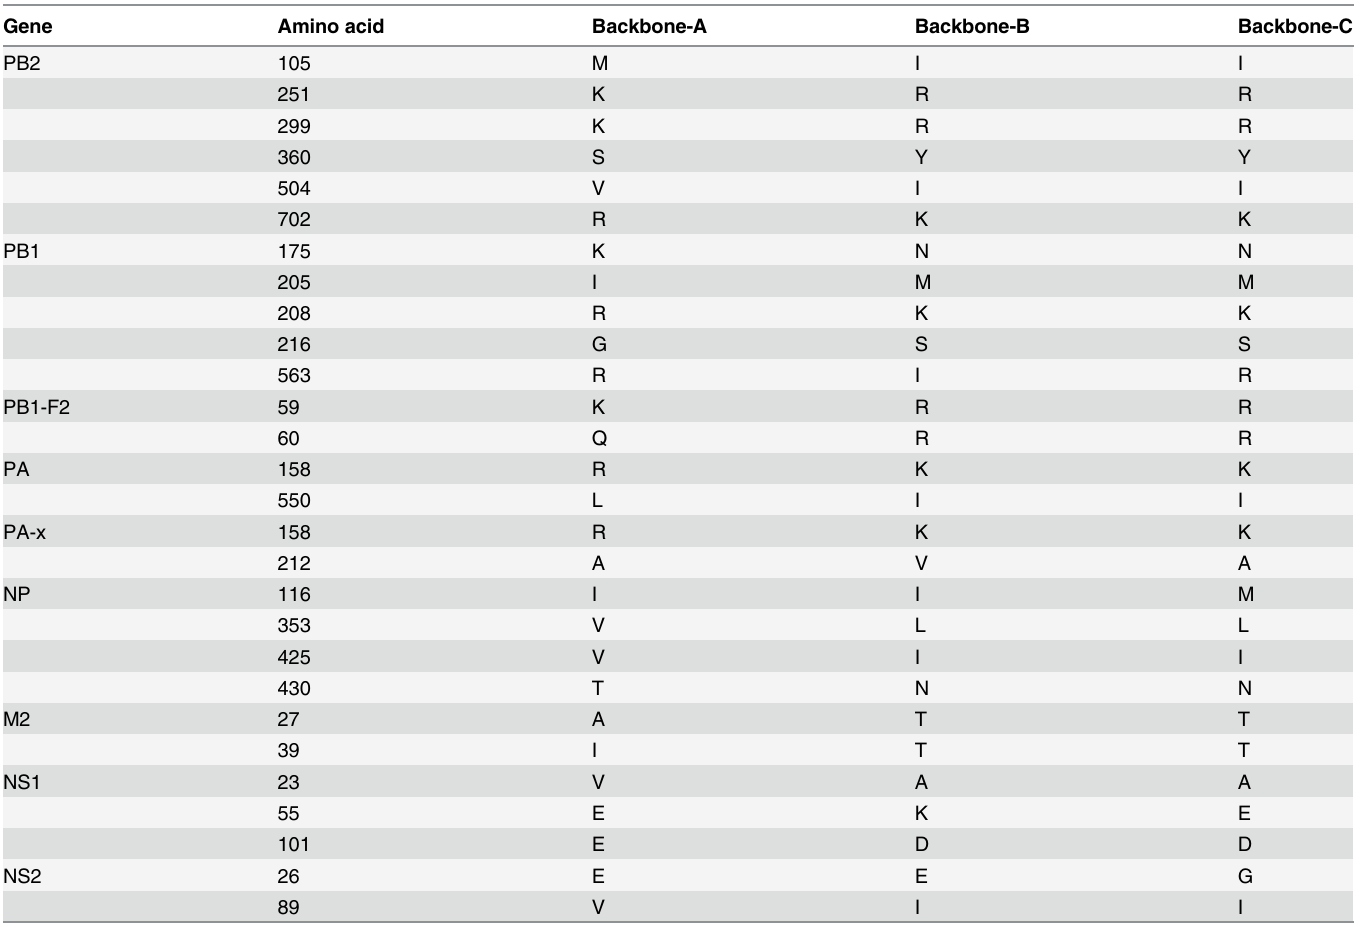
Table 1. Amino acid variation among viral proteins encoded by the PR8 internal genes. †